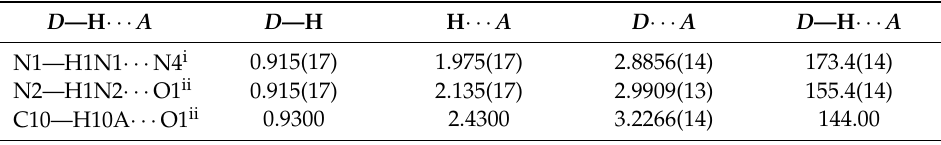
Figure 3. A view of the crystal packing down the b axis for the title compound. Dotted lines indicates the intermolecular interaction. Table 4. Hydrogen-bond geometry (Å, ˝ ) in compound 13